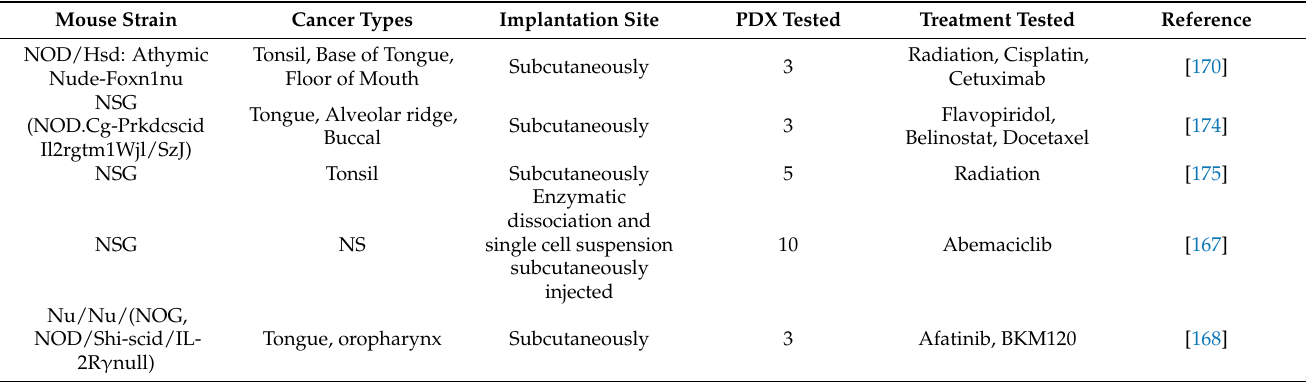
Table 2. Summary of the methods used for patient-derived xenografts of HNC cell cultures in mice. Mouse